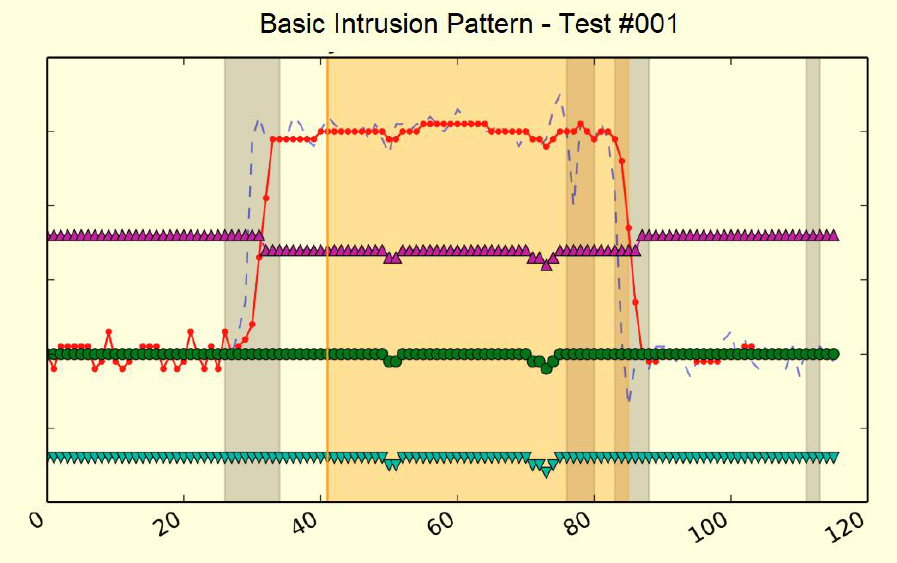
Figure 26. Event sample from the CEMF dataset.